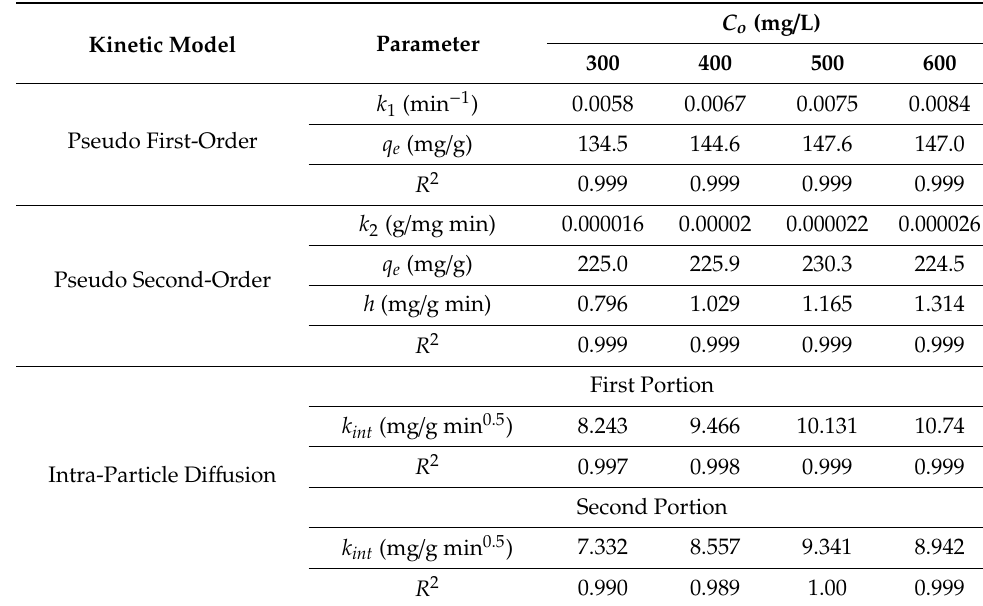
Figure 3. Kinetic models for sorption of benzaldehyde onto iron slag sorbent. Table 2. Kinetic parameters for the adsorption of benzaldehyde onto iron slag.